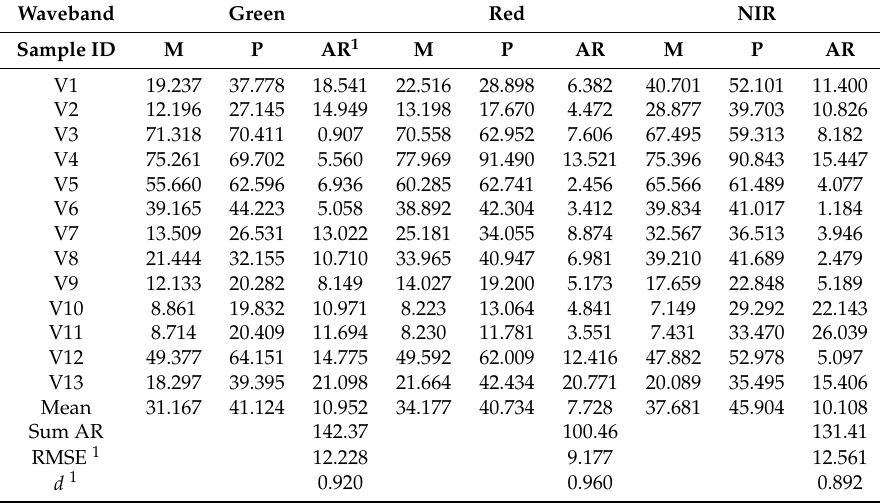
Table 15. Measured (M) and EL2-predicted (P) mean spectral reflectance (%) of 13 validation samples using EL1 Dulux intercept.